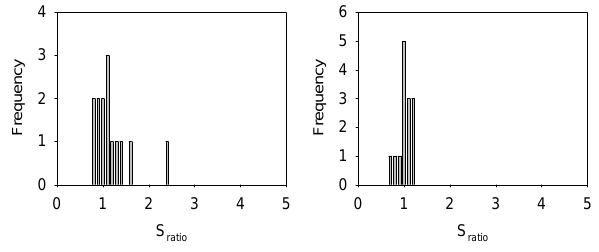
Fig. 9. Histograms of entropy fluctuations in 1-h up and down- Fig. 9. Histogramsofentropy fluctuationsin1hourupanddownstreamregionsof2shockwaves. Leftpanel: Shockwith (cid:9)(cid:10)(cid:1)(cid:1)(cid:0)(cid:5)(cid:7)(cid:3)(cid:2) onday326, 1996 stream regions of 2 shock waves. Left panel: Shock with r B = 2.54 showingtheshockentropytransitionratioof2.33. Rightpanel:Shockwith (cid:9)(cid:10)(cid:1)(cid:3)(cid:6)(cid:5)(cid:7)(cid:5)(cid:4) onday246,1996showingtheshockentropytransitionembeddedin thebackgroundfluctuations. on day 326, 1996 showing the shock entropy transition ratio of 2.33. Right panel: Shock with r B = 1.56 on day 246, 1996 showing the shock entropy transition embedded in the background Fig. 8. Magnetic field variance in 3 components and magnitude(4 panels) using bins of 60 seconds of data for shock on day 296, 1997. The three components are in the standard heliospheric r,t,n coordinate system.